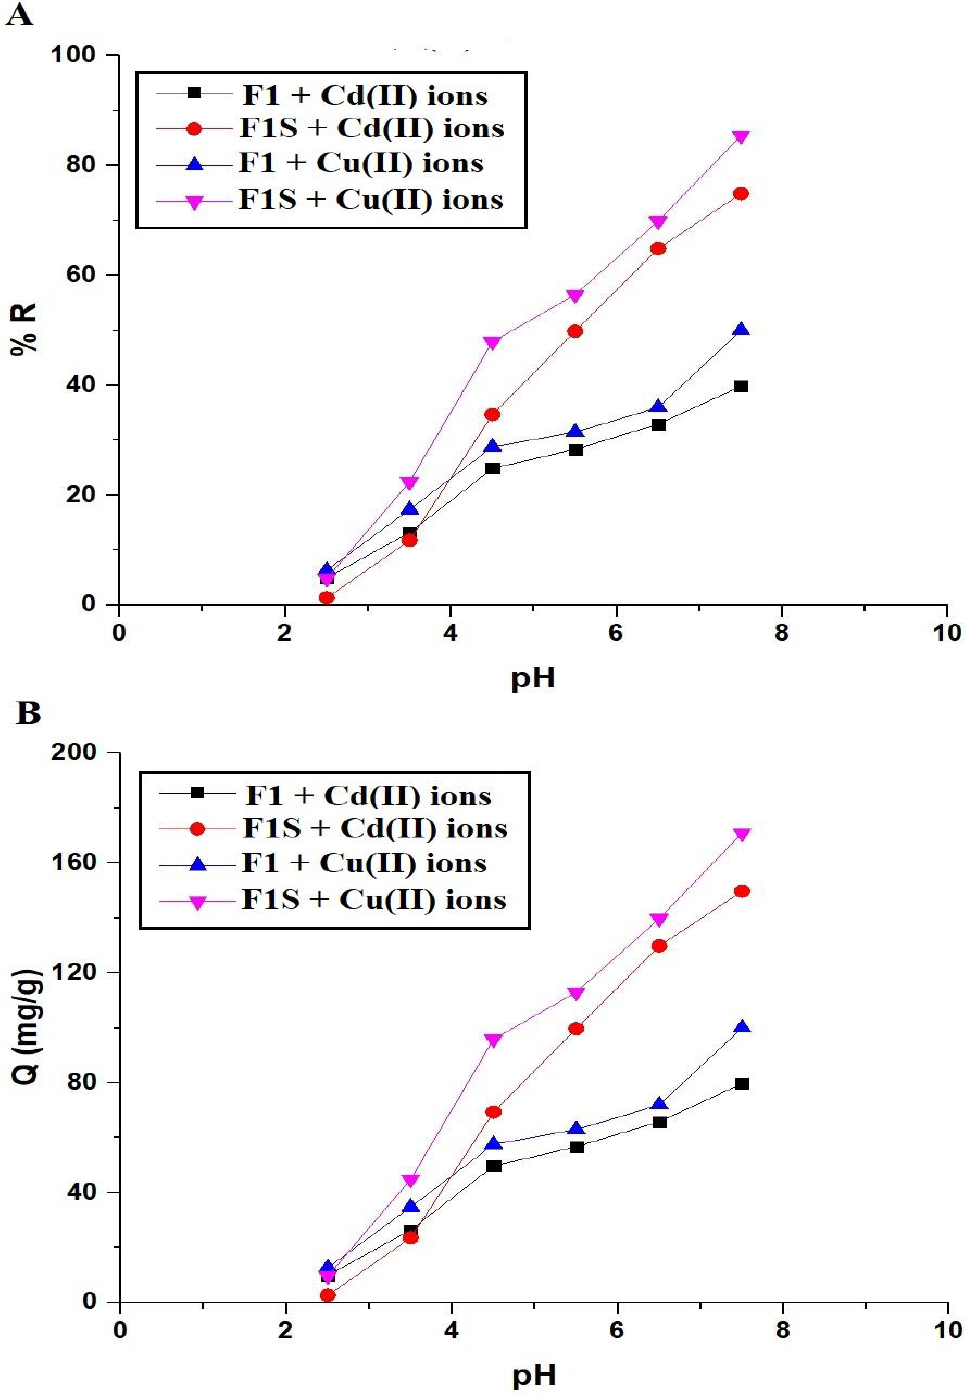
Figure 6. The effect of pH on the % removal of copper and cadmium ions ( A ) and the adsorption capacity of the F1 and F1S samples ( B ). Experimental conditions: concentration = 200 mg/L, volume = 40 mL, amount of adsorbent = 0.04 g, and time = 180 min.